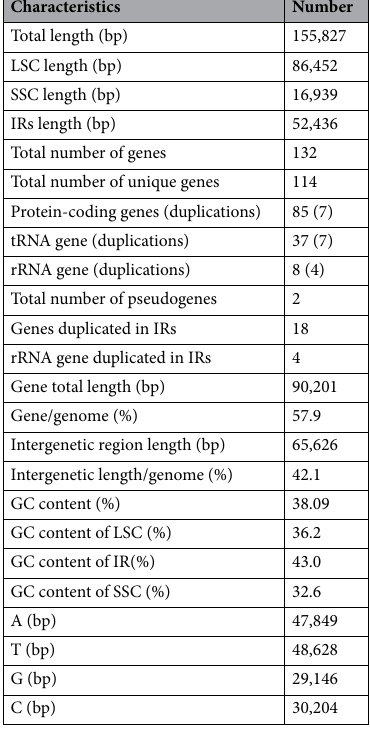
Table 1. Summary of chloroplast genome characteristics of A. episcopale .